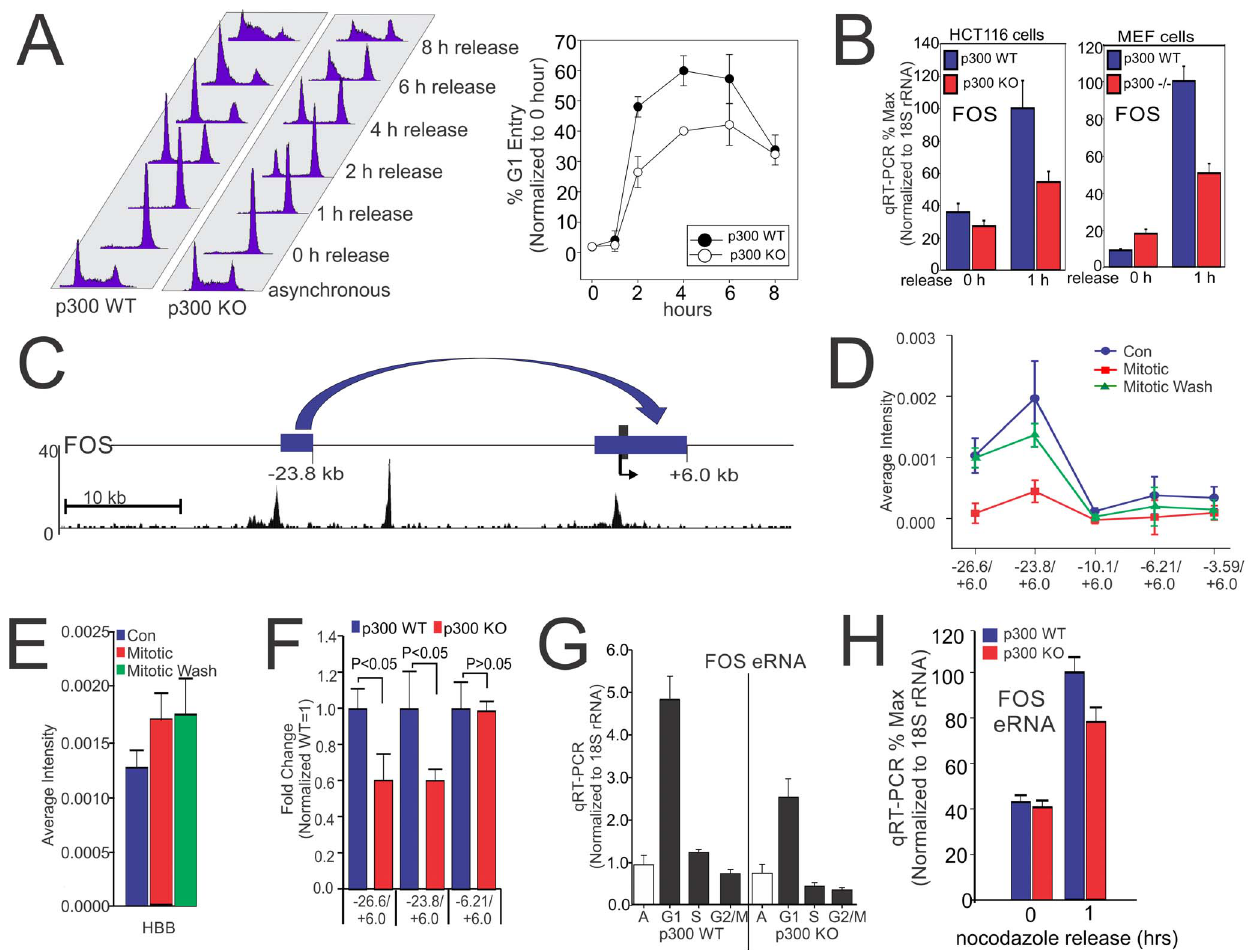
Figure 4. p300 is required for G1 re-entry and re-establishment of long range chromatin interaction at the FOS locus. (A) p300 WT and p300 KO HCT116 cells were treated as in Figure 3B, and released after washing. Cell cycle analysis by flow cytometric (FACS) for DNA content (Propidium Iodide staining) of cell before (Asynchronous) and after release from nocodazole treatment (16 h). Graphical representation of percentage of G1 cells is shown. Error bars represent standard error of the mean from 2 biological replicates. (B) qRT-PCR profile showing expression of FOS in the respective cell lines upon nocodazole treatment and release. Error bars represent standard error of the mean from 2 biological replicates. (C) A schematic of the locations of Chromosome Conformation Capture (3C) sites at the FOS locus relative to TSS with p300 localization as determined by ChIP-Seq. Jurkat cells were treated as in Figure 3A and washed and collected after 2 h. 3C assay was carried out and average intensity of PCR bands of respective primers of the FOS locus [Chr 14: 74822063 ( + 6.0 kb), 74788795 ( 2 26.6 kb), 74791374 ( 2 23.8 kb), 74805069 ( 2 10.1 kb), 74808985 (